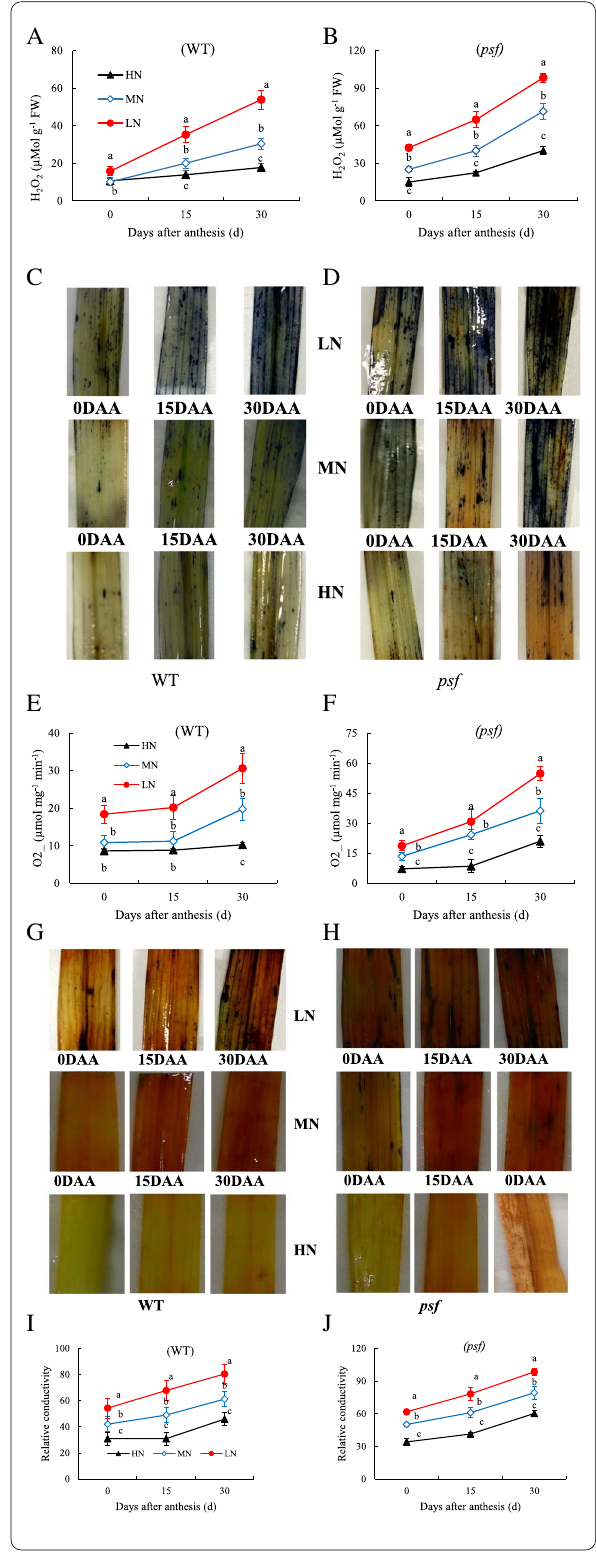
Fig. 5 Impact of N deficiency/overfeeding on ROS bust and membrane integrity in the flag leaves of wildtype and psf mutant during senescence: A , B H 2 O 2 accumulation, C , D NBT staining, E , F O 2 concentration, G , H DAB staining, and I , J relative conductivity. Data are means of SD ( n 3), different letters indicate a significant ± = difference between treatments at a particular sampling period ( P < 0.05)